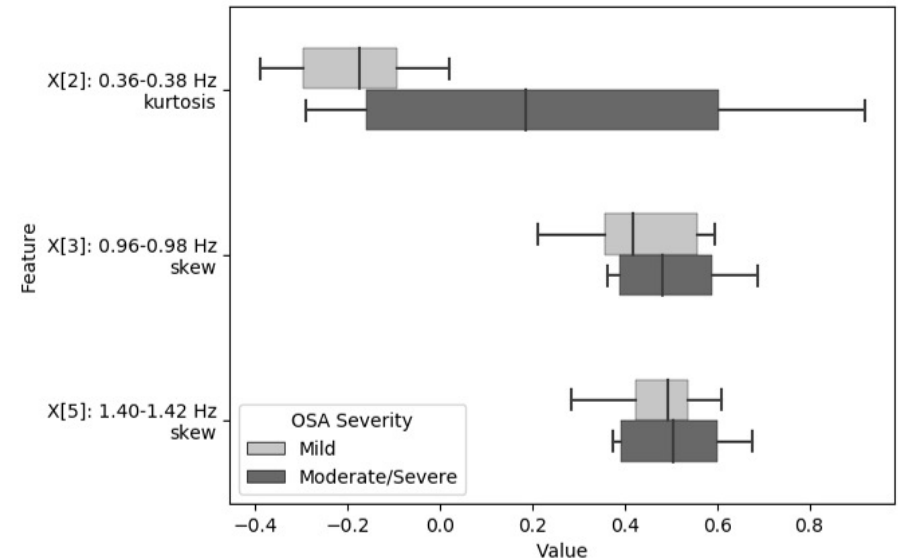
Figure 5. Statistical distribution of spectral features used for Apnea Hypopnea Index (AHI) estimation grouped by clinical OSA